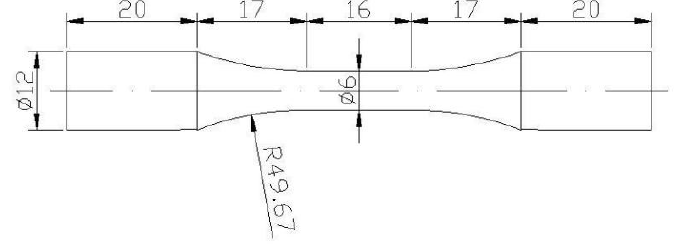
Figure 3. Geometric dimensions of specimens for the strain-controlled low cycle fatigue test.